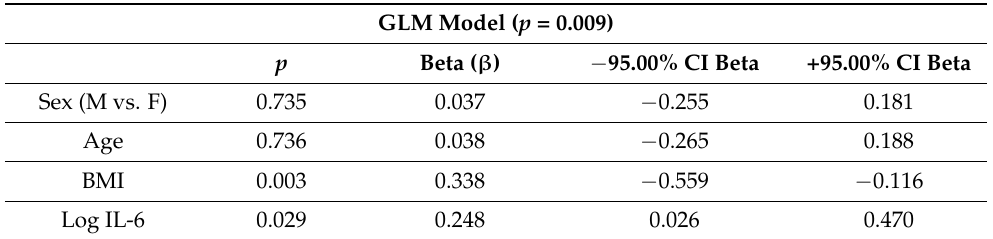
Table 7. General Linear Model (GLM) analysis of independent determinants of log-transformed ERI value in terms of body composition and biochemical data; n =